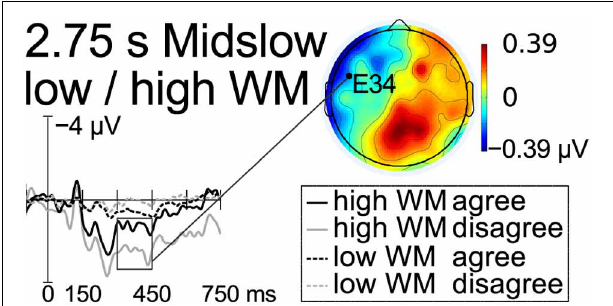
FIGURE 5 | Results at midslow word presentation rate for two groups scoring highest and lowest on the working memory span test, respectively, at a left anterior electrode. The negativity at left channels for the high span group in the LAN time window is shown.